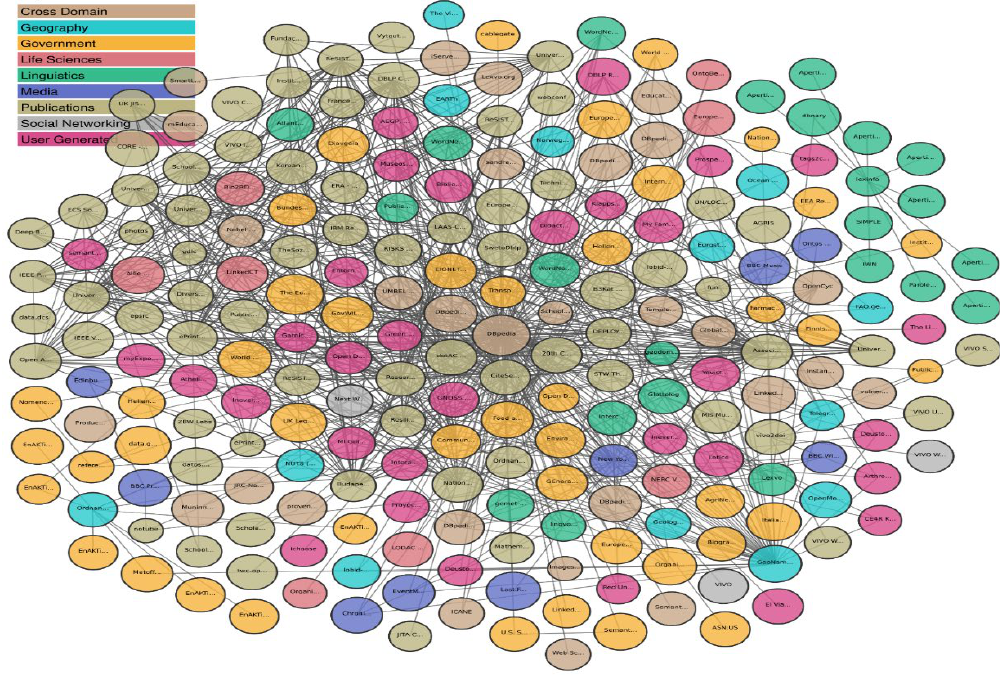
Figure 1. Linked open data cloud from